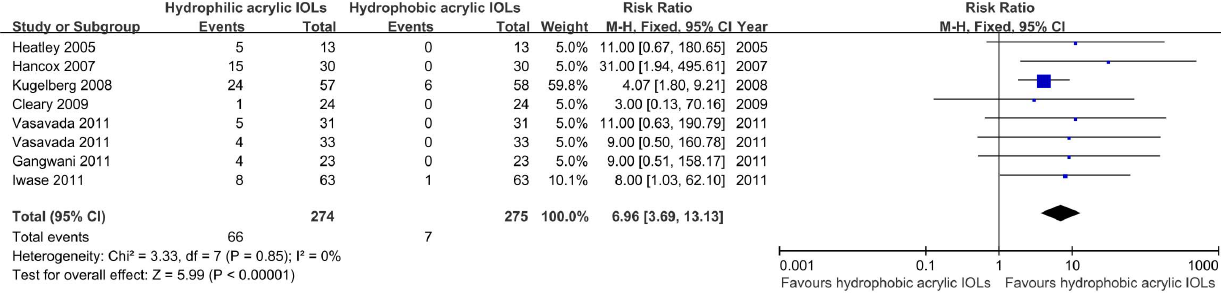
Figure 4. Forest plots describing Effects of hydrophobic acrylic versus hydrophilic acrylic IOLs on rate of Nd:YA Gcapsulotomy in 2- year follow-up. (Chi 2 = chi square statistic, CI = confidence interval, df = degrees of freedom, I 2 = I-square heterogeneity statistic, IV = inverse variance, RR = risk ratio, Z = Z-statistic).